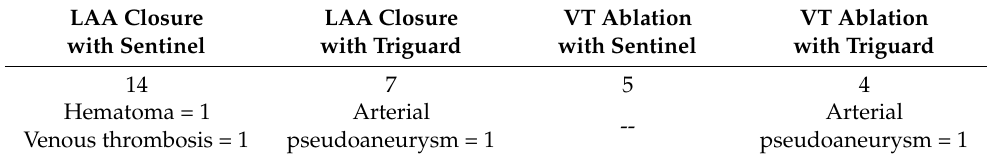
Table 2. CPD-related